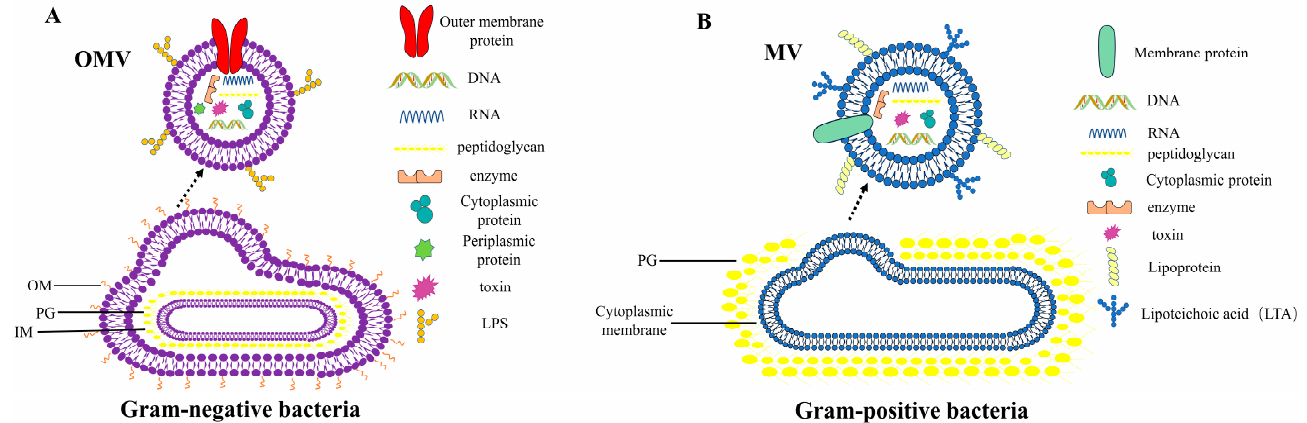
Figure 1. Structure and composition of BMVs. ( A ) OMVs and (B) MVs.